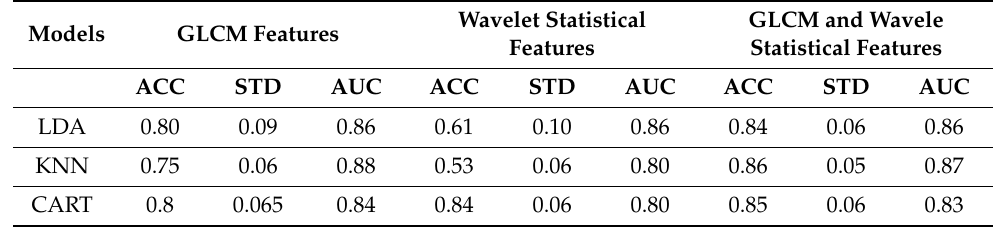
Table 1. Summary of mean accuracy, standard deviation, and area under the curve for Haar wavelet.